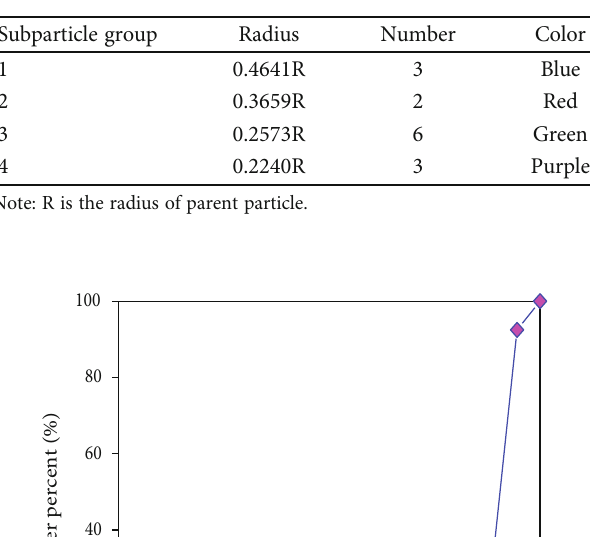
Figure 1: Replacement mode of particles in the sample. Table 1: Distribution information of di ff erent subparticles.